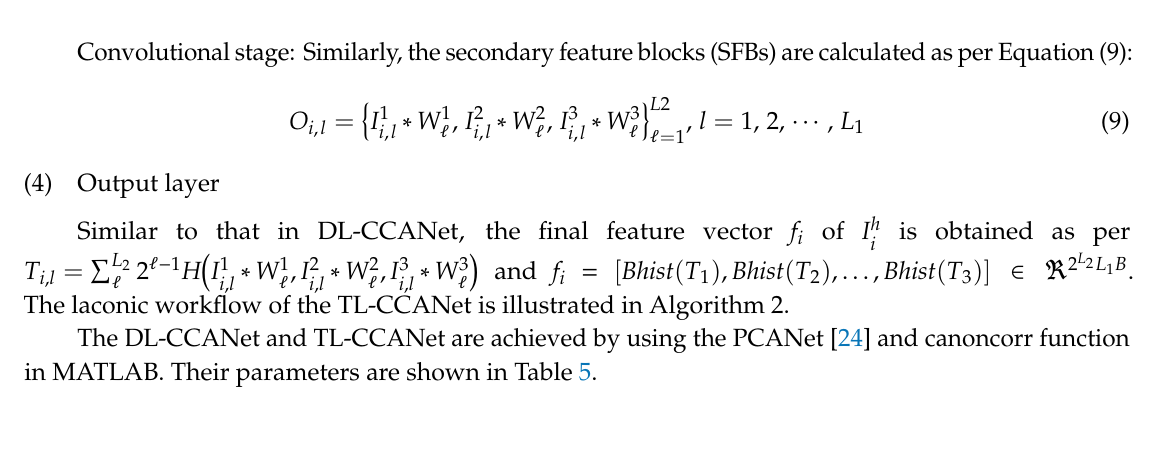
Algorithm 1. The algorithm of two convolutional stages of the DL-CCANet.